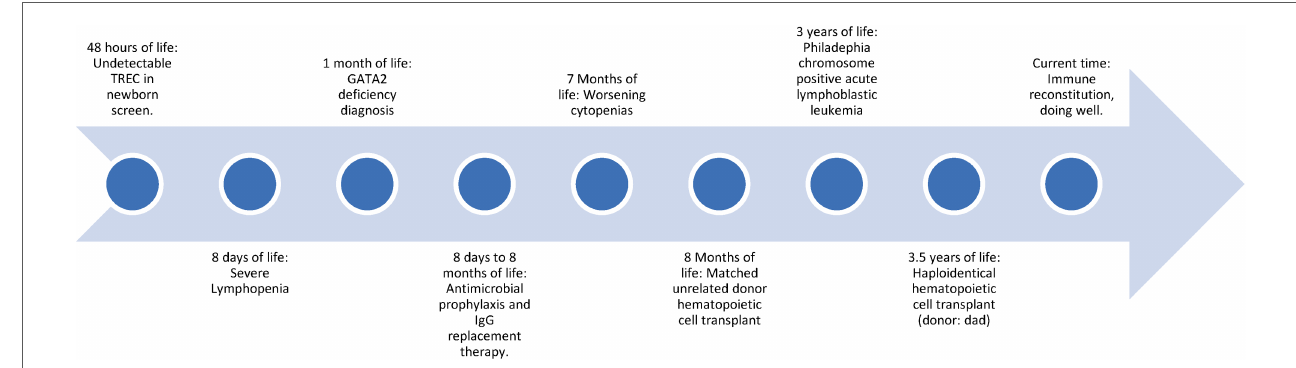
FIGURE 1 Timeline of events of patient